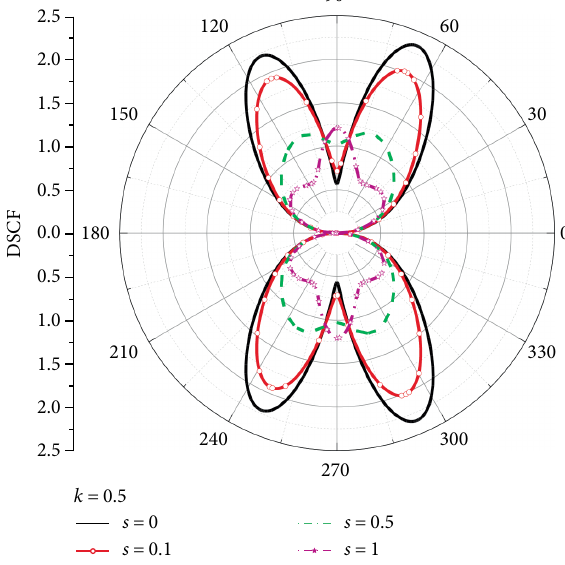
Figure 4: Distributions of DSCF around a circular hole with various 𝑠 for 𝐾 = 𝜋 .